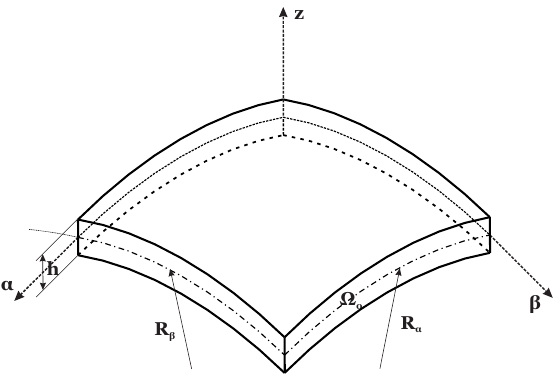
Figure 1. Reference system and notations for the generic shell